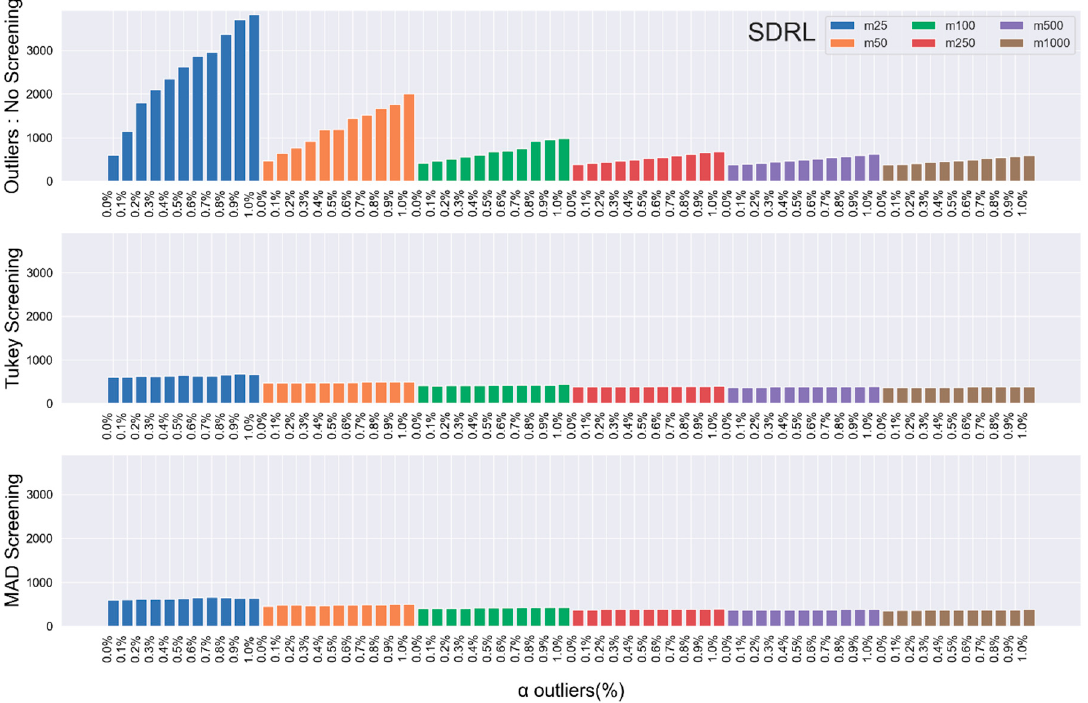
Figure 5. In-control SDRL values for the Shewhart chart from t-( v = 100) distribution in the presence of outliers with and without outlier screening.